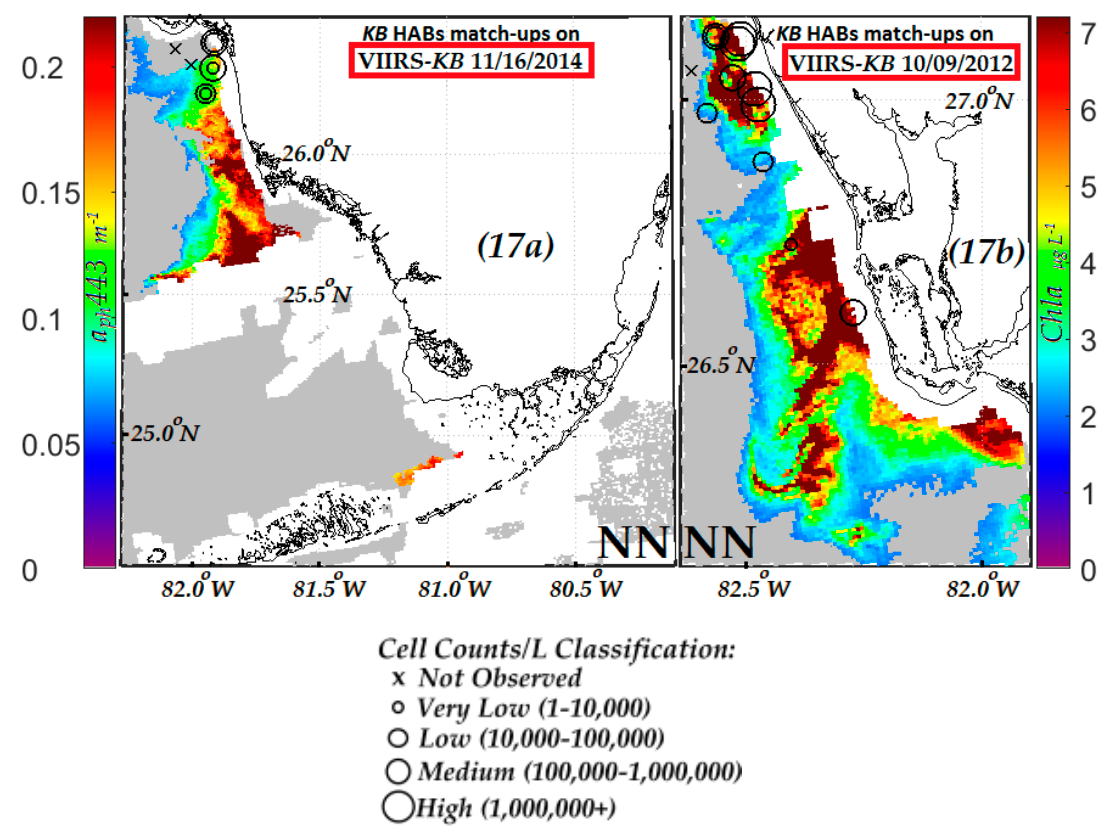
Figure 17. VIIRS-NN KB HABs retrievals on 2 different blooms dates, showing bloom compatible a ph 443 and equiv. [ Chla ] values. ( a ) 11 November 2014, bloom; ( b ) 09 October 2012, bloom. Notes all images are overlaid with cell counts corresponding for these dates. White areas represent cloud cover or invalid data.